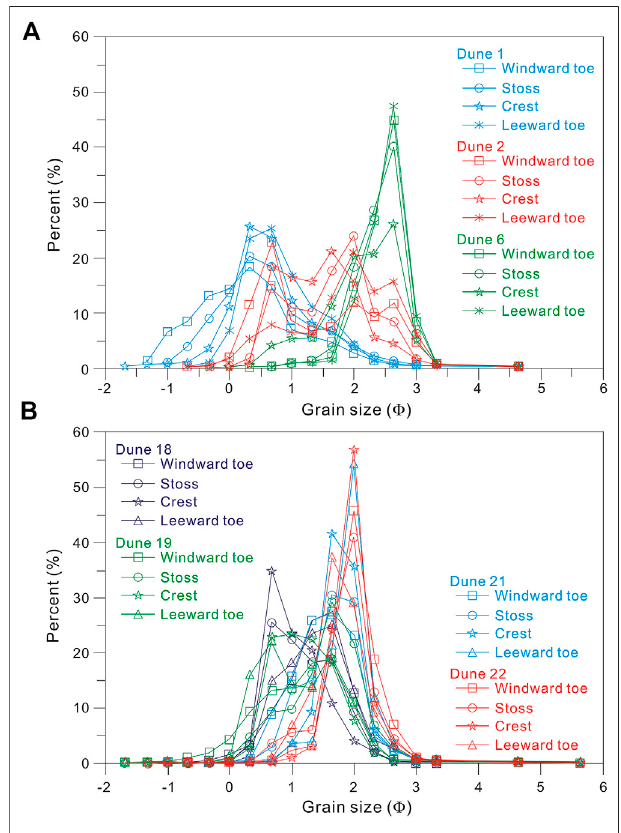
FIGURE 5 | The frequency distribution curves of grain size of dune sediments in the Hexi Corridor (modi fi ed from Zhang and Dong (2015)).